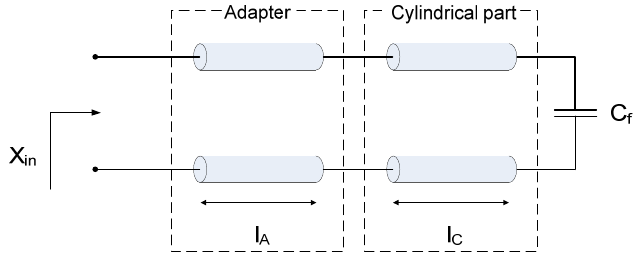
Figure 4. The transmission-line model of the proposed sensor. Lengths of the transmission = H = 44 mm, l = 24.5 mm, fringing capacitance C lines are l c C A